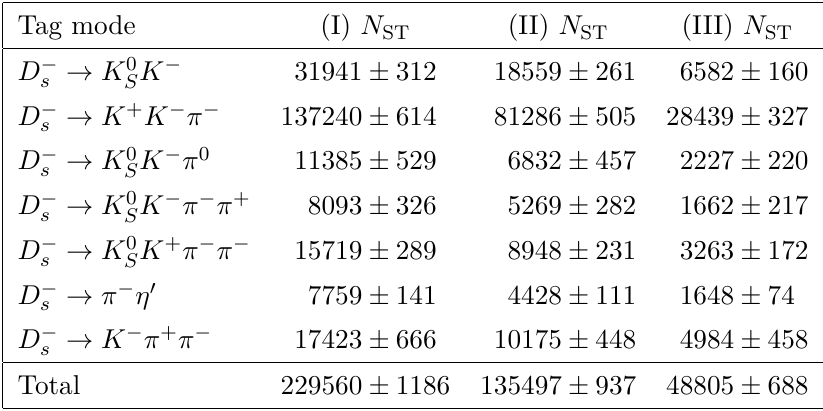
Table 7 . The ST yields for the samples collected at (III) 4.226 GeV. The uncertainties are